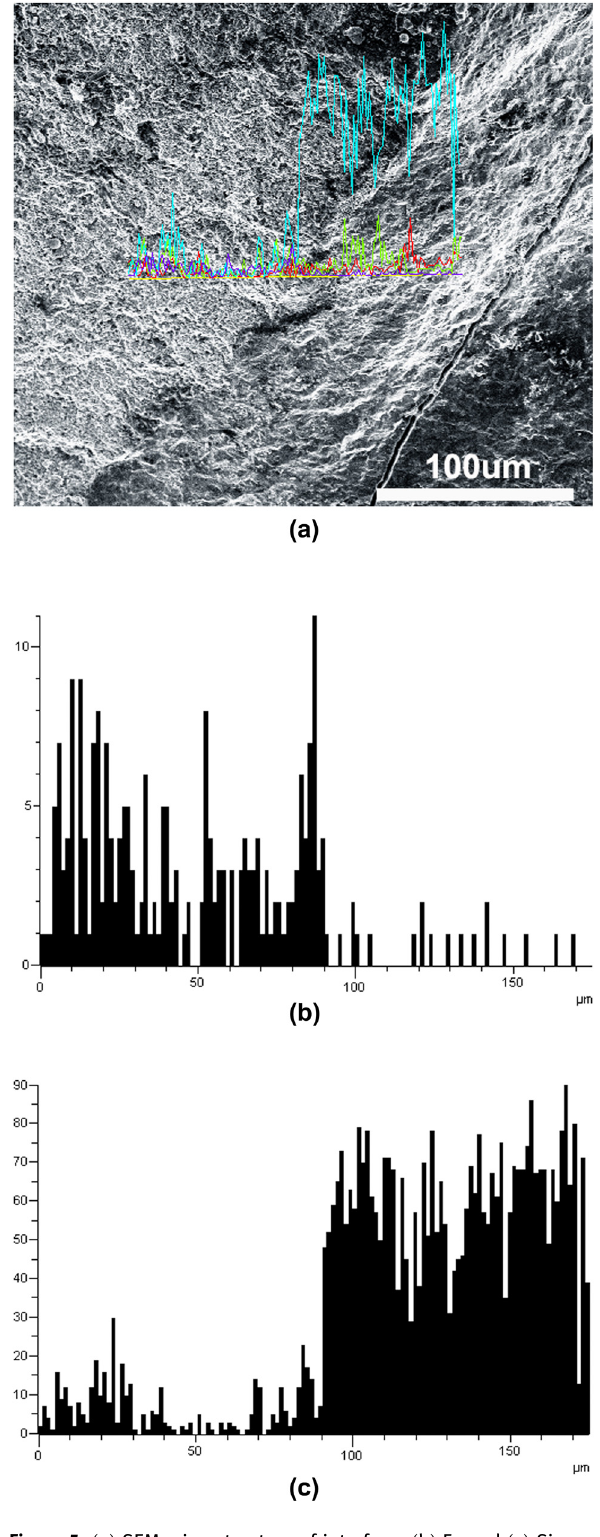
Figure 5: ( a ) SEM microstructure of interface, ( b ) Fe and ( c ) Si alloying elements distribution at